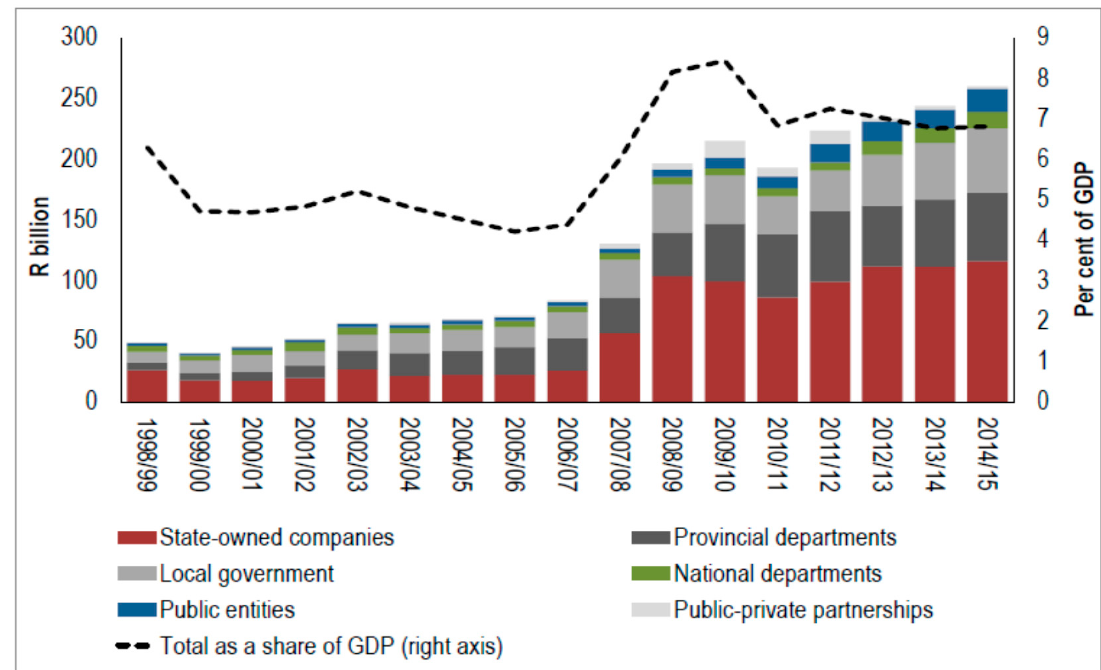
Figure 1. Public sector infrastructure spending 1998/99–2014/15 (National Treasury Budget Review, 2016).